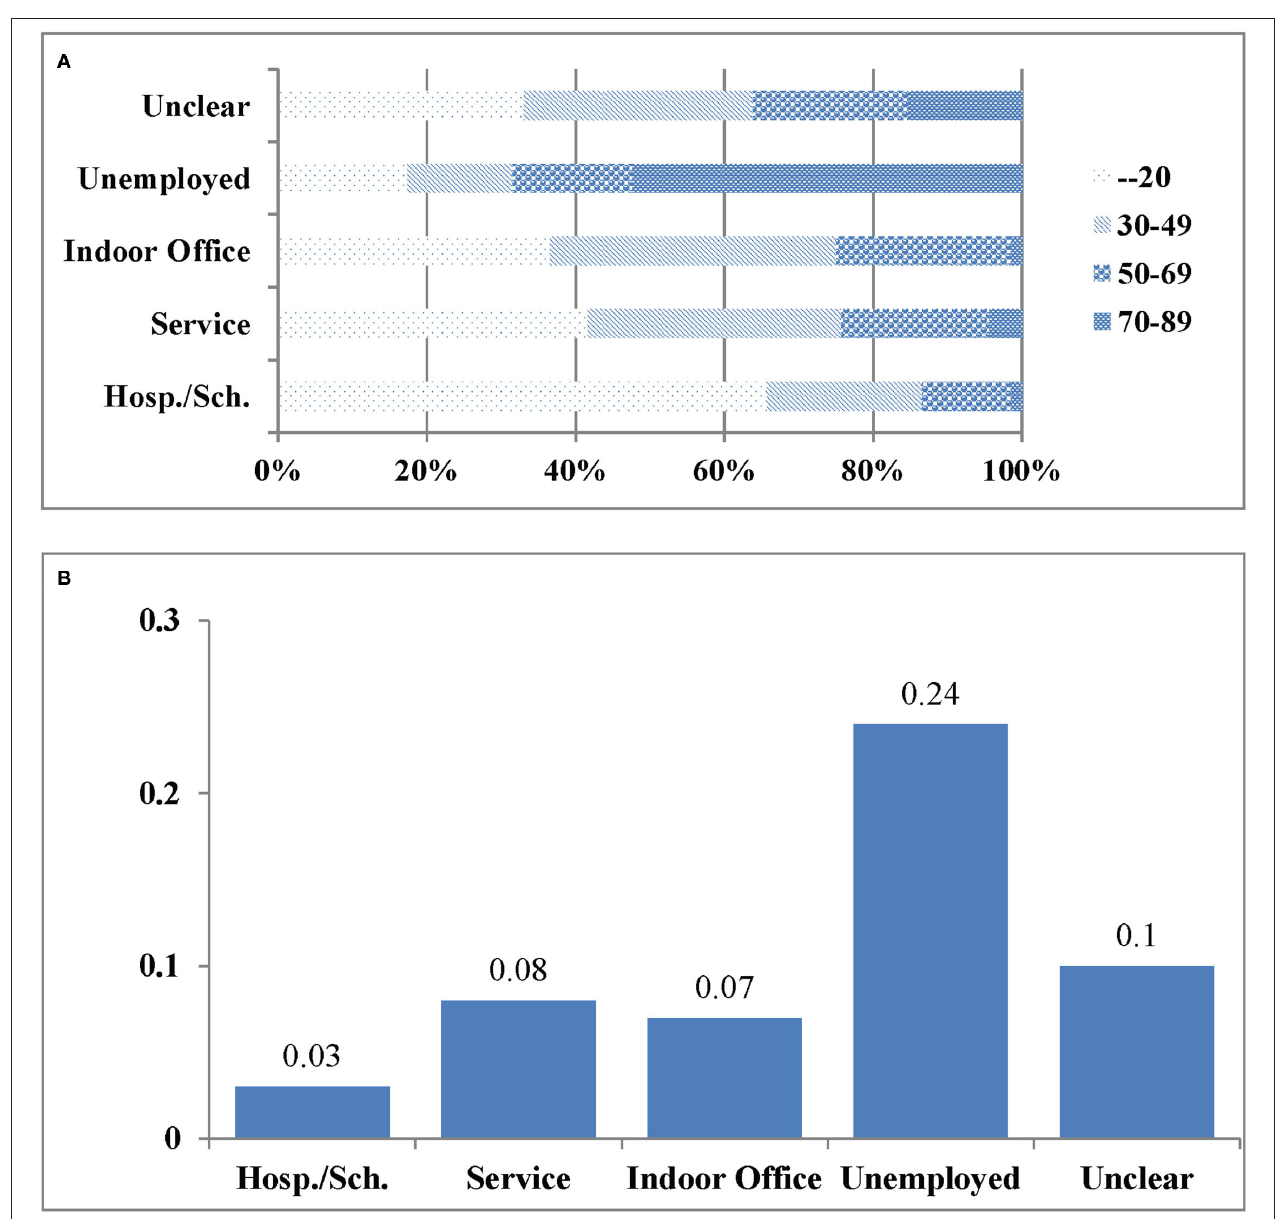
FIGURE 3 | (A) The distributions of age by workplace. (B) The proportion of comorbidity by workplace.